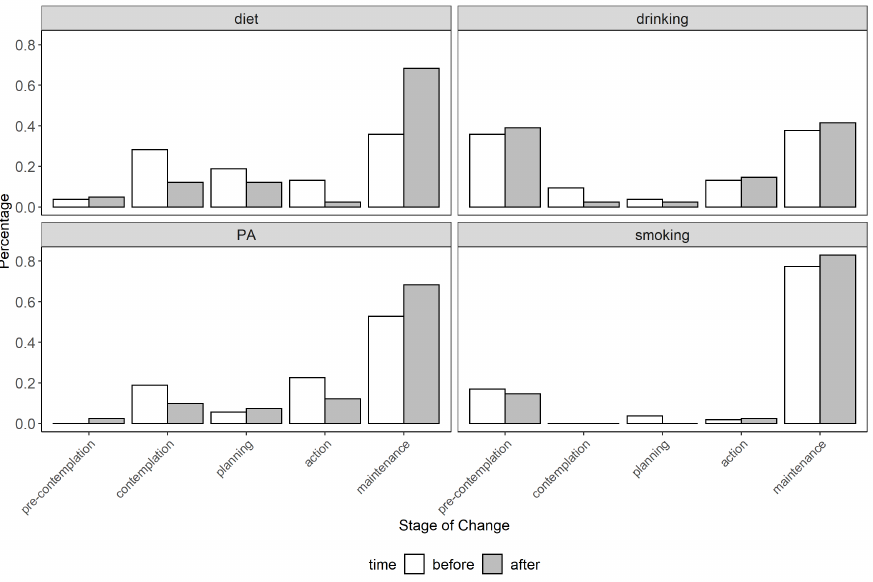
Figure 3. Participants’ stages of change in the four behavioral domains before and after the